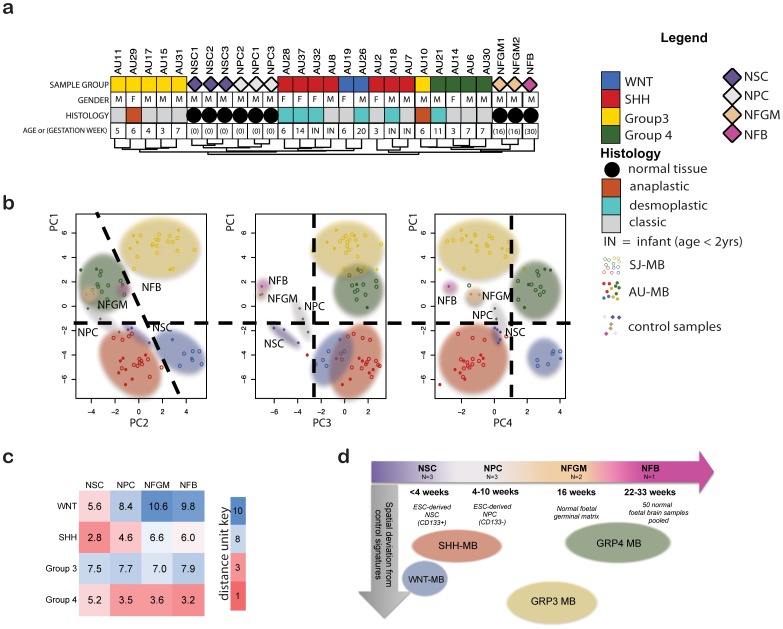
Alignment of molecular subgroups to developmental controls.
a. Unsupervised clustering using global expression signatures of the AU-MB cohort and developmental controls is displayed with patient gender, age and tumor histology features. b. Multivariate analysis of combined AU-MB and SJ-MB cohorts using 20-gene molecular subgroup classifiers. Spatial distribution of medulloblastoma subgroups and developmental control samples is graphed for the first four largest variances. Medulloblastoma subgroup variance in the context of control samples is best displayed by PC1, 2 and 4. c. Distance measures of control versus medulloblastoma subgroups by geometric distance of group centroid in the variance dimensions PC1 and PC2. The arbitrary distance units were graphed on a blue (far) to red (close) scale. d. Interpretation of spatial and temporal association of clustering alignment analyses. Geometric distance of medulloblastoma subgroups to all control samples groups is schematically graphed in distance along the temporal brain development axis (x-axis) and spatial axis (y-axis, average distance of subgroup to all control groups). AU-MB – Australian medulloblastoma cohort (solid symbols), NFB - normal fetal brain, NFGM - normal fetal germinal matrix, NPC - neural progenitor cells, NSC - neural stem cells, PC – principal component, SJ-MB – St Jude medulloblastoma cohort (open symbols).